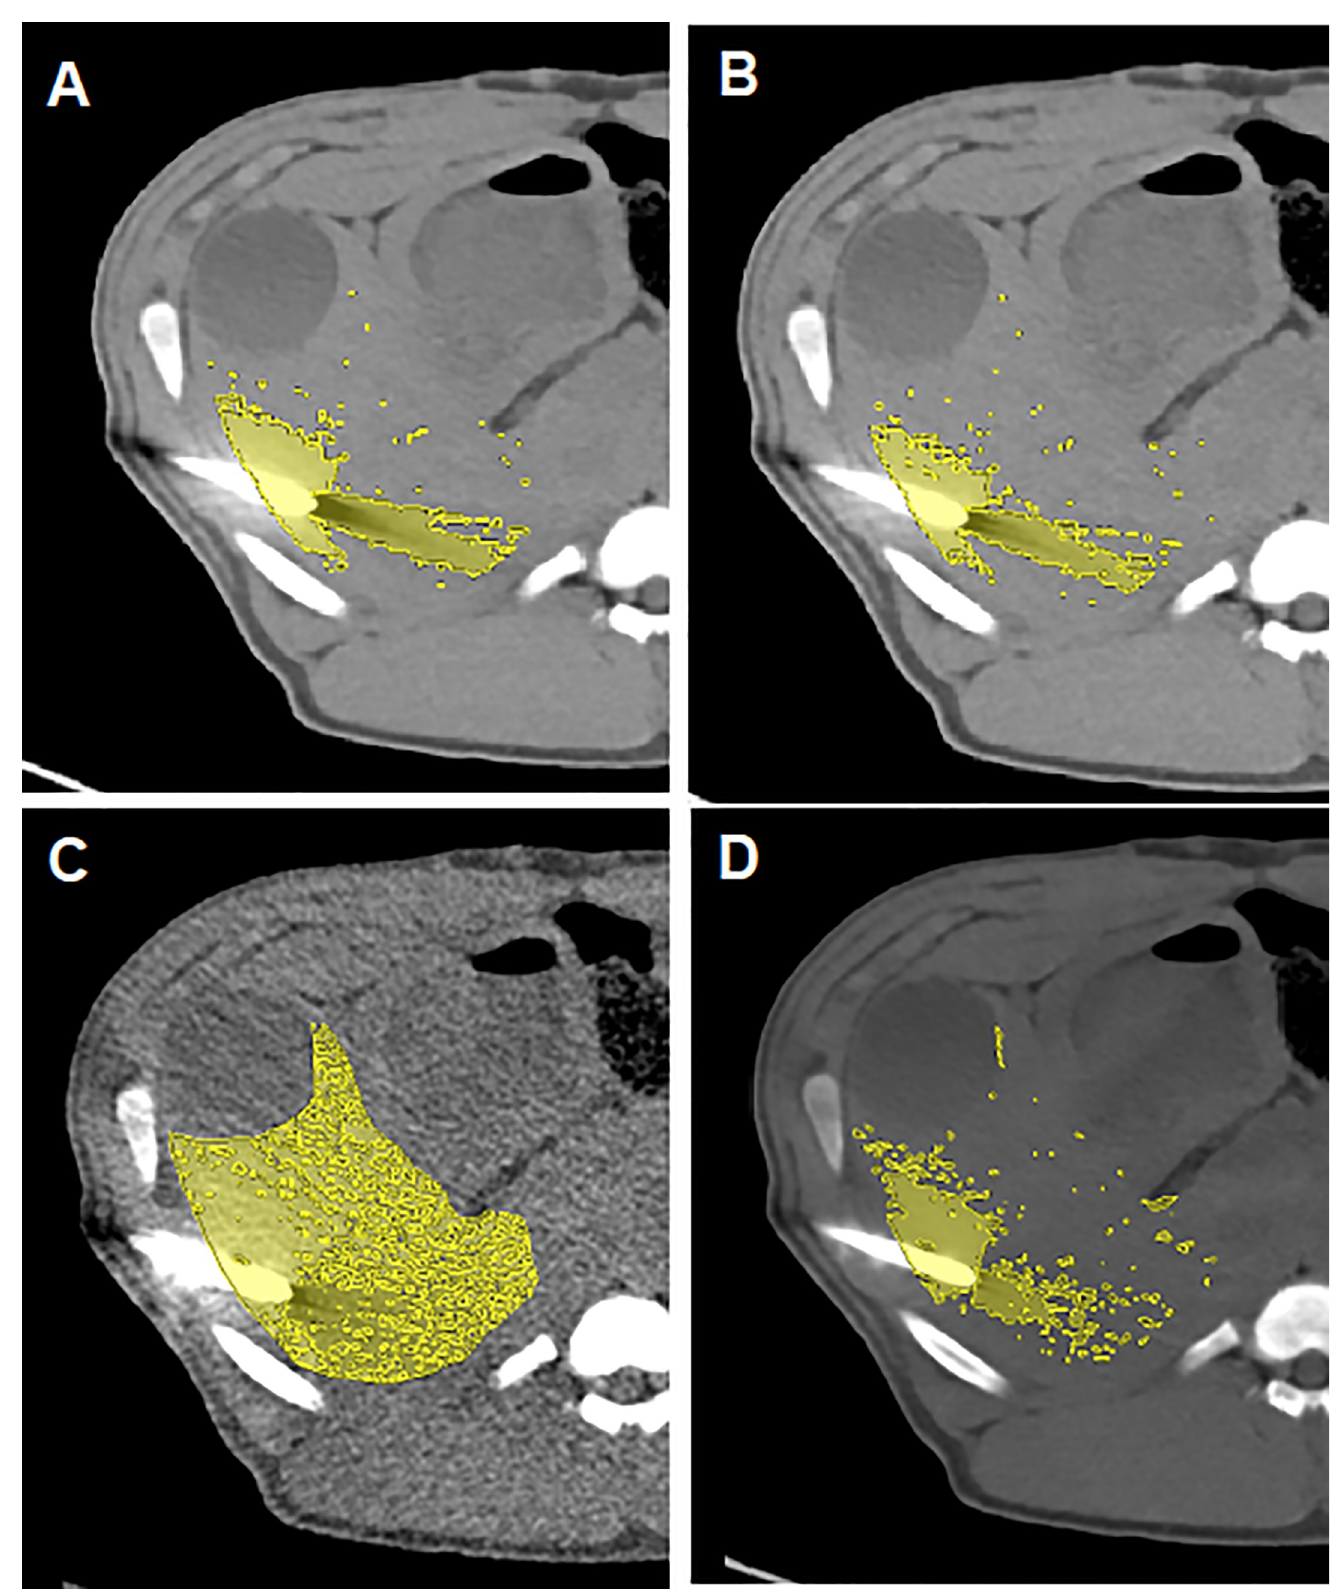
Fig 2. Artifacts based on semi-automated segmentation for SE I30-3 with iMAR (A) and without iMAR (B), VMSI 40 keV iMAR (C) and VMSI 80 keV iMAR (D). https://doi.org/10.1371/journal.pone.0228578.g002 PLOS ONE | https://doi.org/10.1371/journal.pone.0228578 February 10,